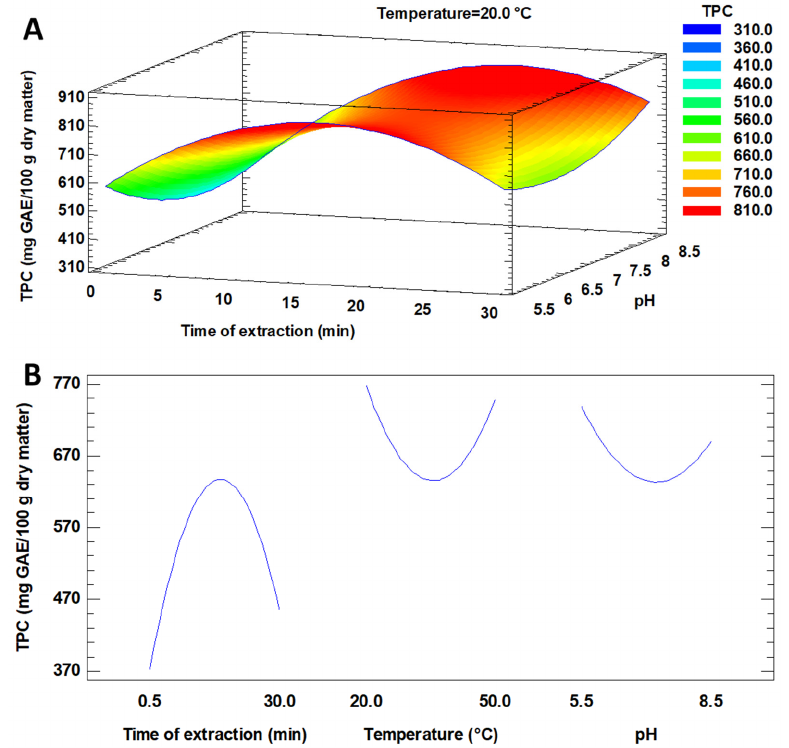
Figure 5. Influence of the different extraction conditions ( A ) and main effects chart for these condi- tions ( B ) on the total phenolic compounds (TPC) recovery yield (mg/100 g dry matter). The least relevant factor (highest p -value) has been set at its optimal